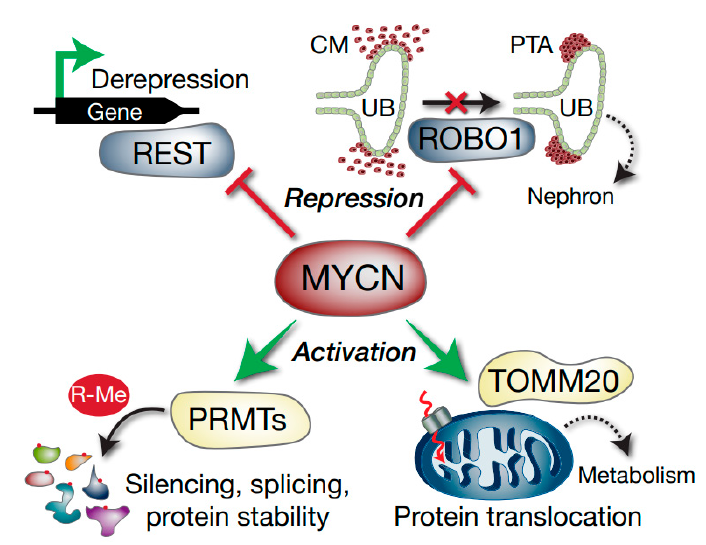
Figure 8 . Model depicting select Wilms’ tumour MYCN targets with potential functional consequences. MYCN represses the REST tumour suppressor gene, which can result in activation of REST-repressed genes. ROBO1 is also repressed, which may compromise the differentiation of the condensing mesenchyme (CM) into pre-tubular aggregates (PTA) via inhibition of SLIT–ROBO developmental signalling. The ureteric bud (UB) is also shown. MYCN activation of methylo- some genes such as PRMTs alters arginine methylation (R-Me), with subsequent alterations in functions including mRNA splicing and protein stability. Activation of TOMM20 by MYCN may lead to aberrant mitochondrial protein translocation (dashed red arrow) and altered tumour cell